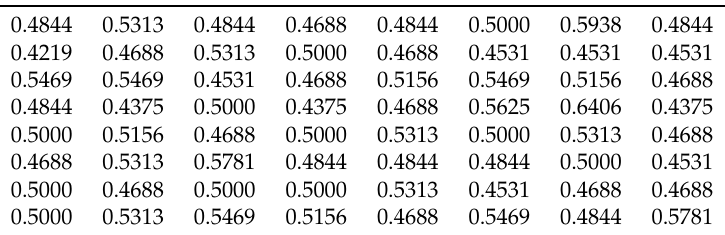
Table 4. The obtained dependence matrix.